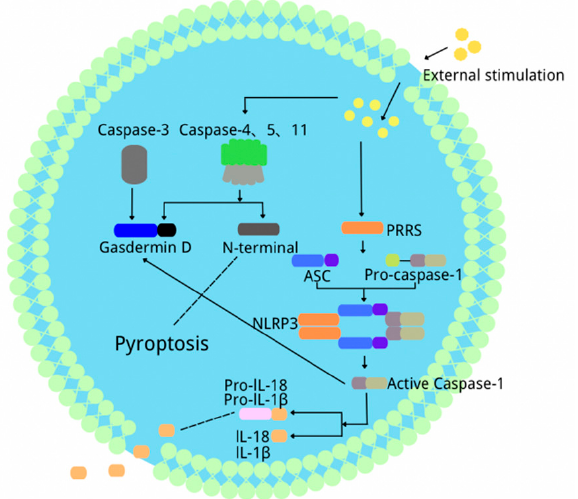
Figure 1. The schematic diagram of the process of three types of pyroptosis.